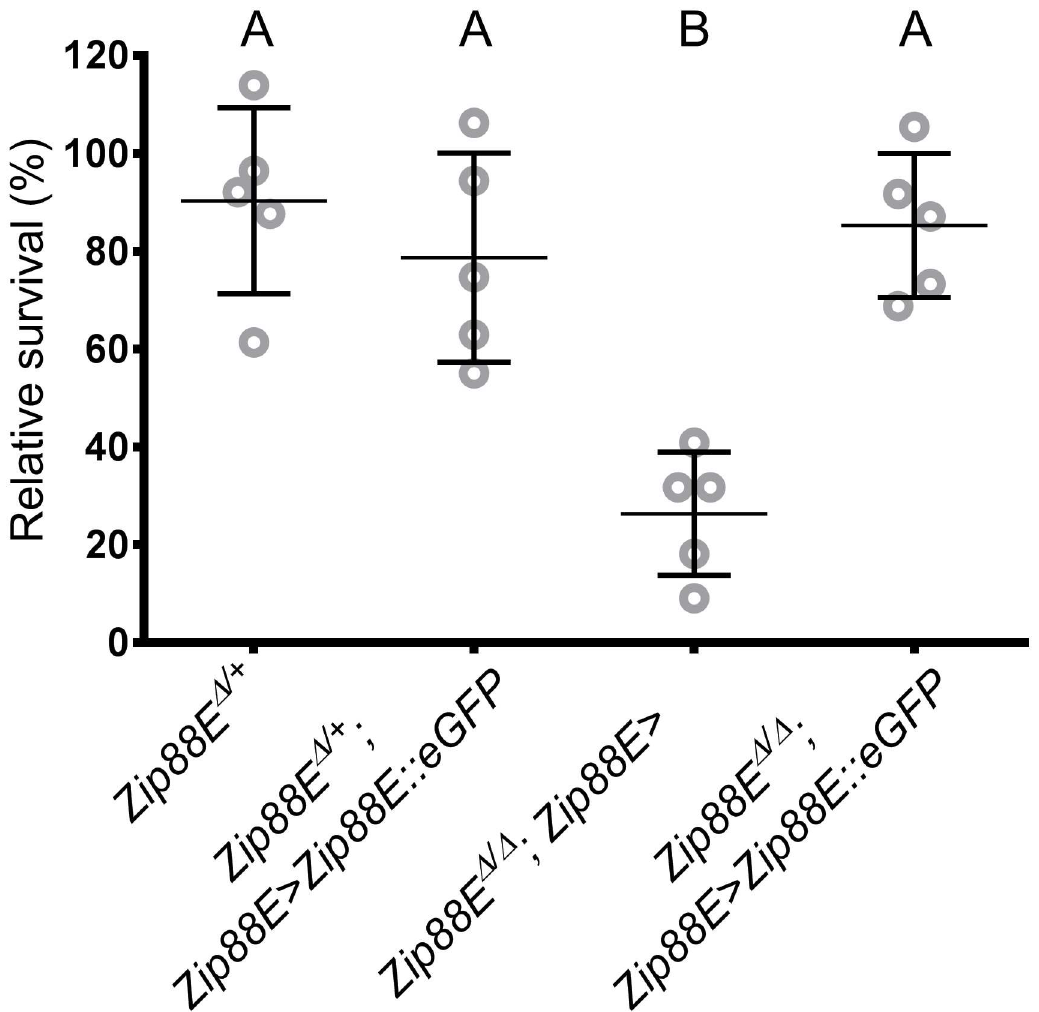
Fig 7. Zip88E expression in the Zip88E-GAL4 expression domain restores dietary zinc tolerance to Zip88E Δ / Δ mutants. Mean survival rate of flies raisedfrom first instar larvae on 4 mmol l -1 ZnCl 2 -supplemented media, relative to survival of the same genotypeon basal media. Over expressionof Zip88E :: eGFP driven by Zip88E-GAL4 results in a significantincreasein survival of Zip88E Δ / Δ mutants, back to levels comparable with heterozygote controls. Expression of Zip88E :: eGFP transgenein heterozygotes had no effect on zinc tolerance. Values are represented as the mean survival relative to survival on basal media ± SD. Means with the same letter are not significantly different. Means with different letters (i.e. A and B) are significantly different (P (cid:20) 0.05, Two-way ANOVA, n = 3).